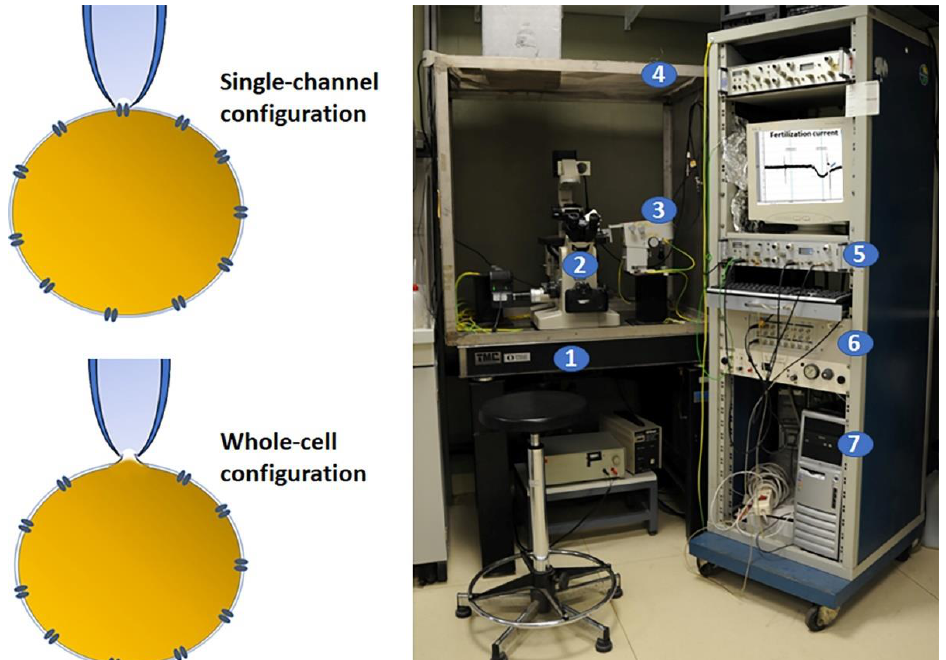
Figure 1. Electrophysiology patch clamp and set up. On the left, a schematic diagram of two recording methods for patch clamp. This technique requires the initial formation of a tight seal between the plasma membrane and the blunt tip of a glass micropipette that is obtained by applying a light suction. In this configuration, the currents flux through the channel into the pipette and can be recorded by an electrode connected to a highly sensitive differential amplifier (single channel) or, by applying a stronger suction, the membrane patch can be ruptured and the interior of the pipette becomes continuous with the cytoplasm, allowing the electrical potentials and currents from the entire cell (whole cell) to be recorded. On the right, the electrophysiology set up that includes: (1) an antivibration air table to minimize mechanical vibrations; (2) an inverted microscope; (3) a micromanipulator for stably positioning the micropipette; (4) a Faraday cage to block external electrical interference; (5) an amplifier to collect and amplify the electrical signals; (6) a digitizer to convert analogue into digital signals; (7) a computer with a proper analytical software. On the PC screen, there is a typical fertilization current recorded in ascidian oocytes.